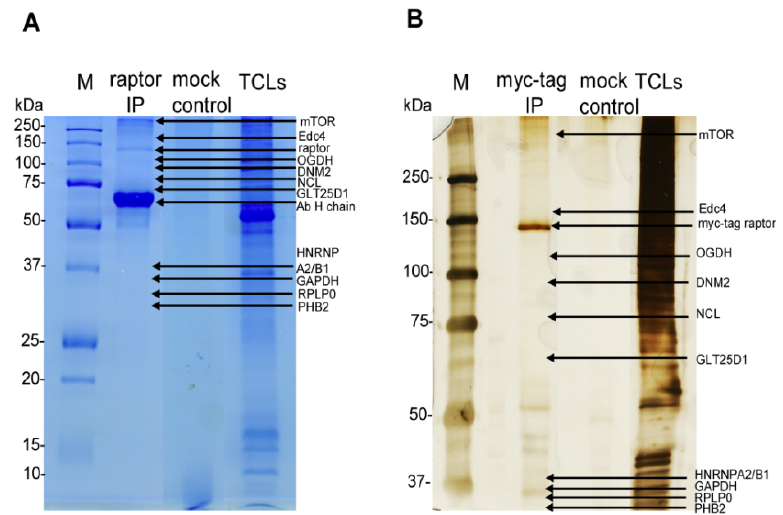
Figure 4. hnRNP A2/B1 and dynamin 2 interact with mTORC1. CCRF-CEM cells